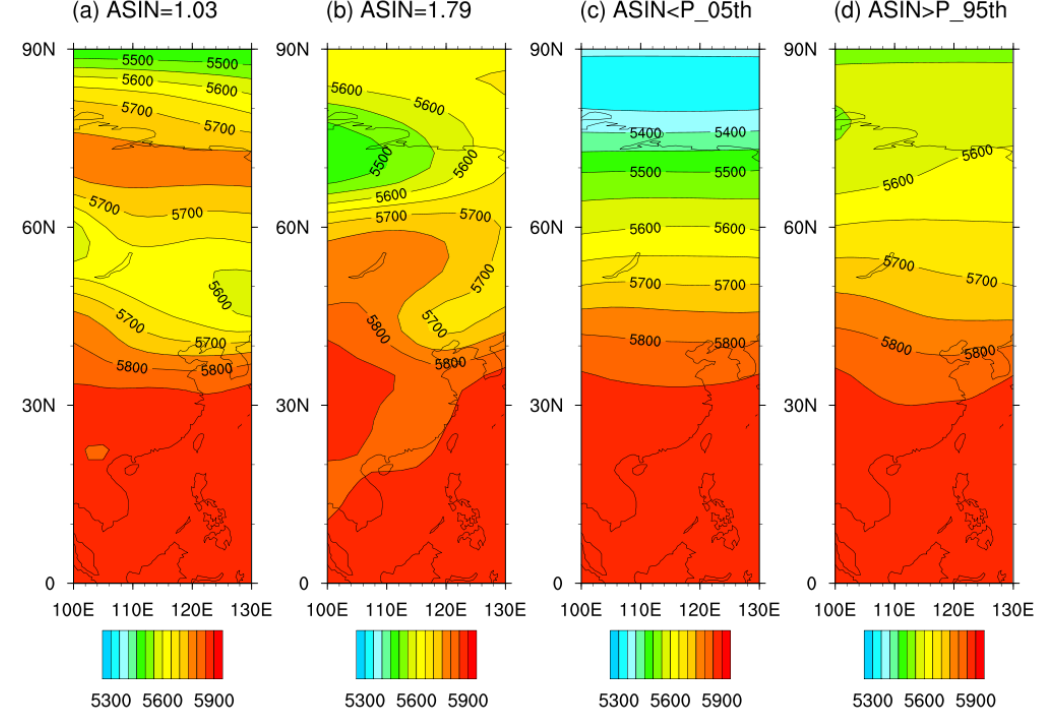
Figure 3. Different circulation states corresponding to different ASIN values in August, illustrated at Z500 (m). ( a ) Lowest (ASIN = 1.03), ( b ) highest (ASIN = 1.79), ( c ) mean of the 5% lowest ASIN days (ASIN<P_05th), ( d ) mean of the 5% highest ASIN days (ASIN>P_95th).